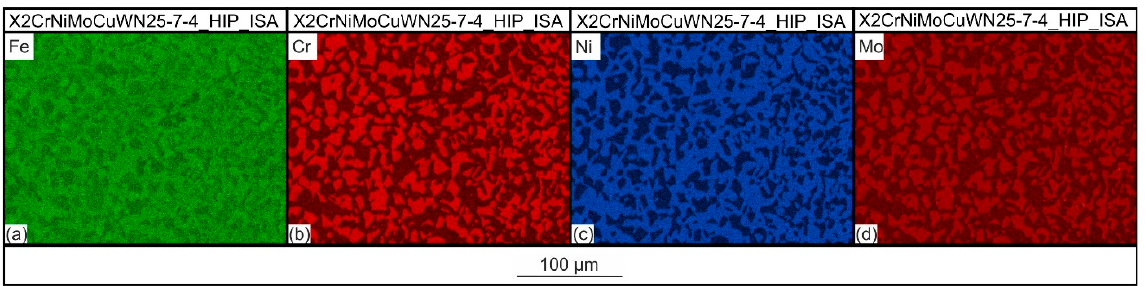
Figure 8. EBSD phase images (a) and grain size mappings (b) of X2CrNiMoCuWN25-7-4_HIP_ISA steel.